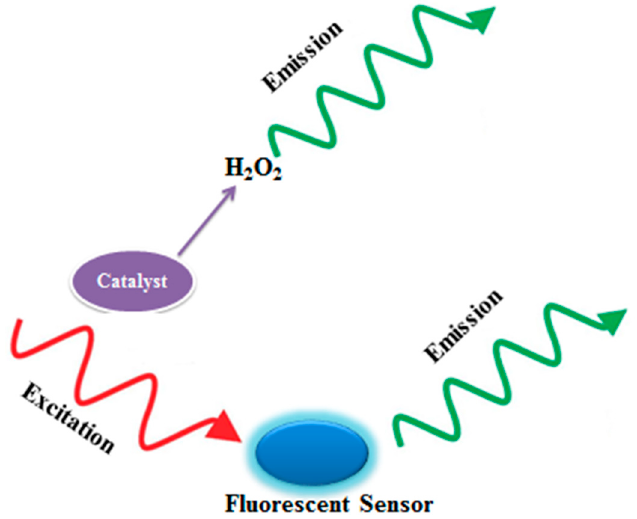
Figure 2. Mechanism of the chemiluminescent material for the detection of H 2 O 2 released in cancer cells. Excitation and de-excitation of chemiluminescence materials can be seen during chemical re-